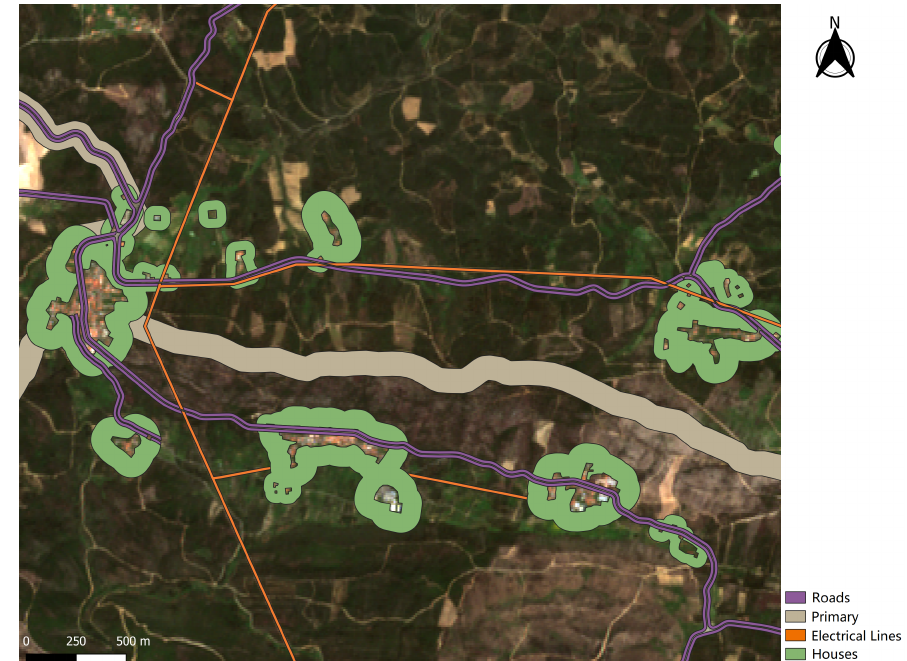
Figure 4. Vector information of Fuel Management Zones (FMZs) in the north of Mação.